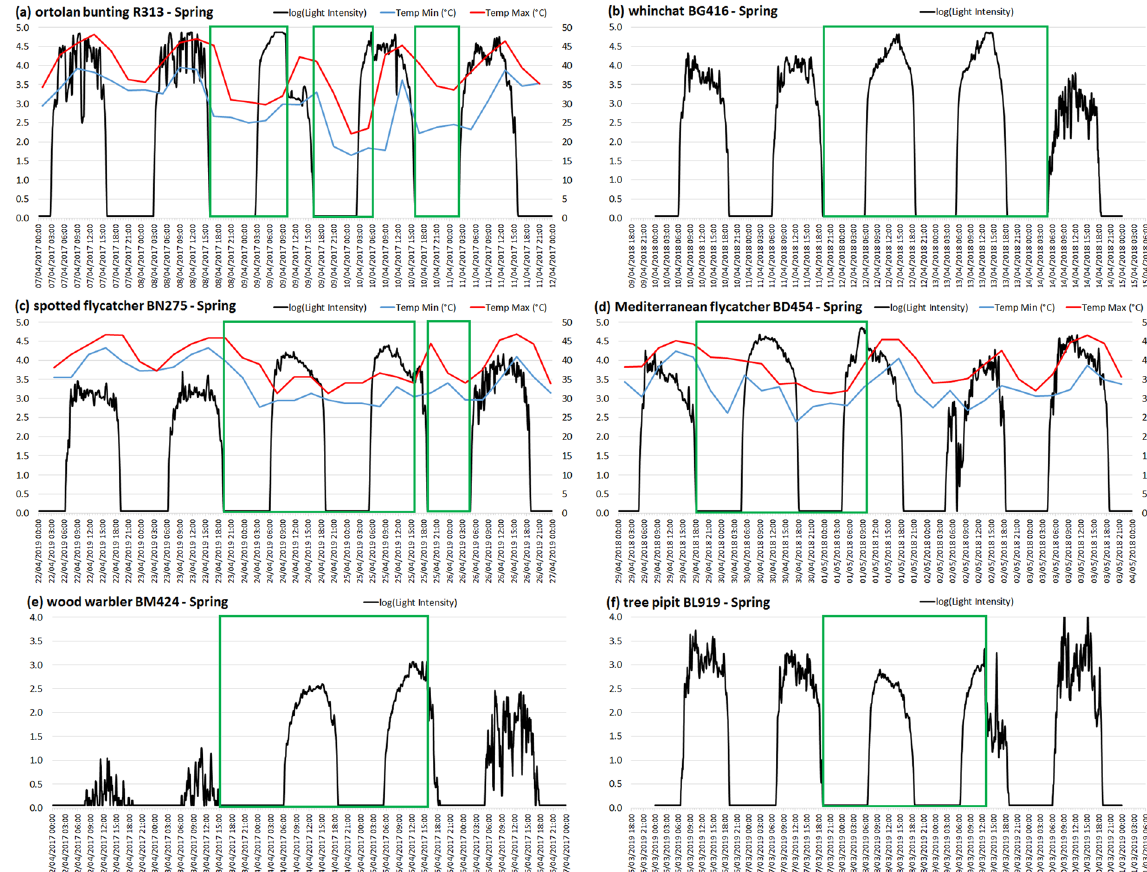
Figure 2. Light intensity (log-transformed) and minimum and maximum temperature (if available) recorded by geolocators during spring desert crossing, for six individuals of different species. Green rectangles represent possible flight bouts. ( a ) ortolan bunting R313: FLPs over two consecutive days, and temperature drops in the third night revealing a third night of active migration at a relatively high altitude; ( b ) whinchat BG416: two full-day FLPs during two consecutive days; species foraging in the open, like whinchat and flycatchers, where a full-day FLP is harder to distinguish from usual patterns than in species foraging in bushes and trees, like wood warbler and nightingale; ( c ) spotted flycatcher BN275: non-stop flight during two nights and a complete day, followed by a prolongation during most of the second day, for a flight bout that lasted potentially up to 45 hours, while the low temperatures during the following night reveal another nocturnal flight bout; ( d ) Mediterranean flycatcher BD454 spring: full-day FLP on the second day, and FLP in the morning of the third day, for a non- stop flight bout that lasted potentially up to 40 hours; ( e ) wood warbler BM424: a non-stop flight that lasted potentially up to 48 hours; ( f ) tree pipit BL919: a non-stop flight that lasted potentially up to 40